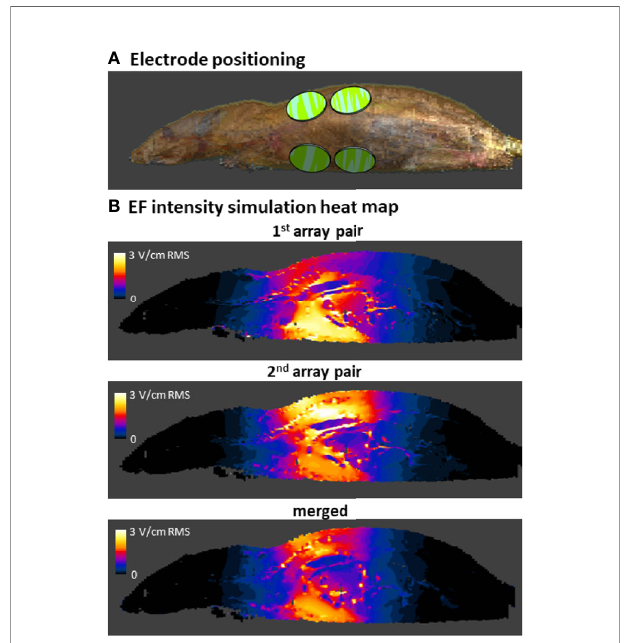
FIGURE 6 | Simulations of EF intensities in the rat torso during 200 kHz TTFields application. Arrays were positioned on the rat model in accordance with their position in the safety study (only 1 side of the animal with 2 arrays is visible) (A) . EF intensity distribution was simulated for 200 kHz TTFields at the current determined relevant from the in vivo study of 280 mA, and is shown from a side view for each of the 2 array pairs and as a merged average image of both (B)